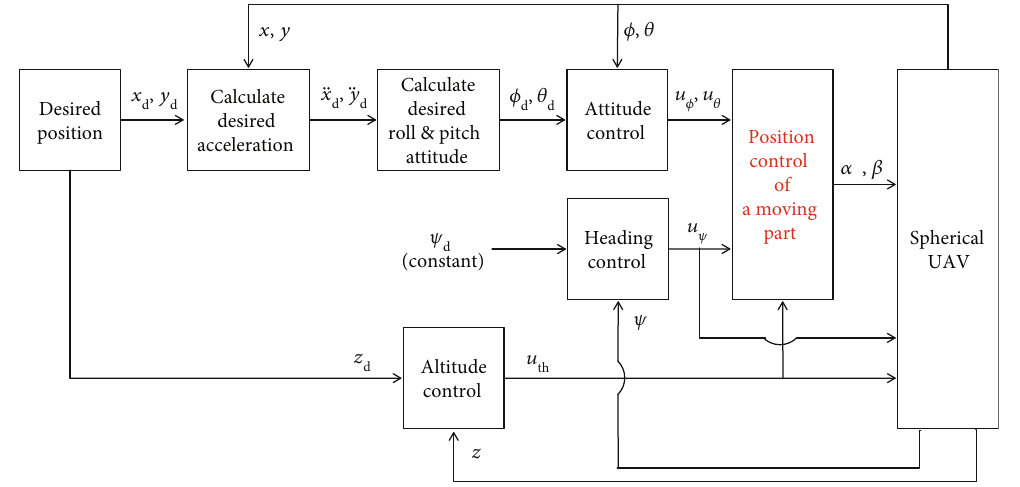
Figure 3: Control structure for the CG variation control